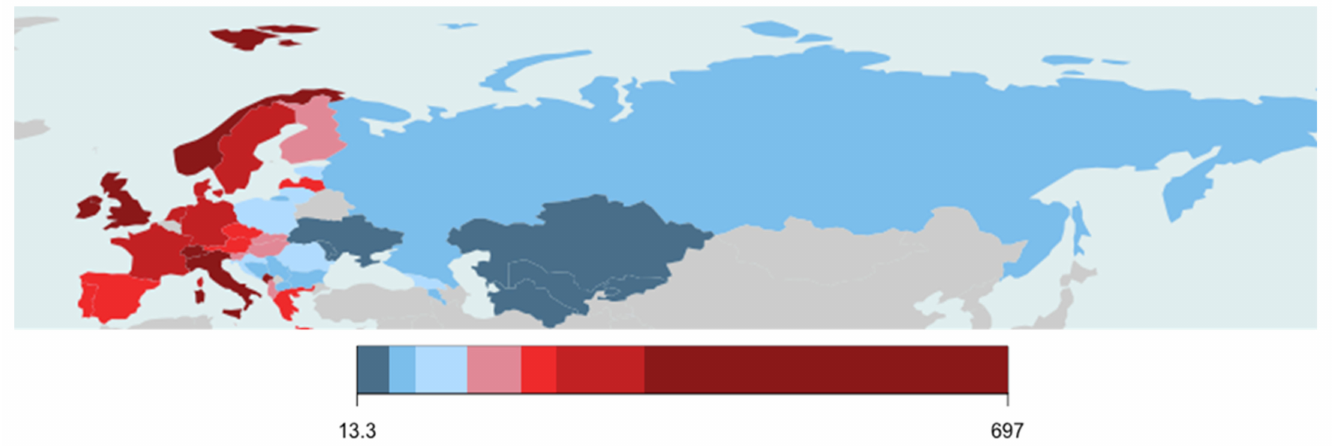
Figure 1. Trade in Value Added (USD) per unit of energy embodied in exports (TJ) (own elaboration on Eora26